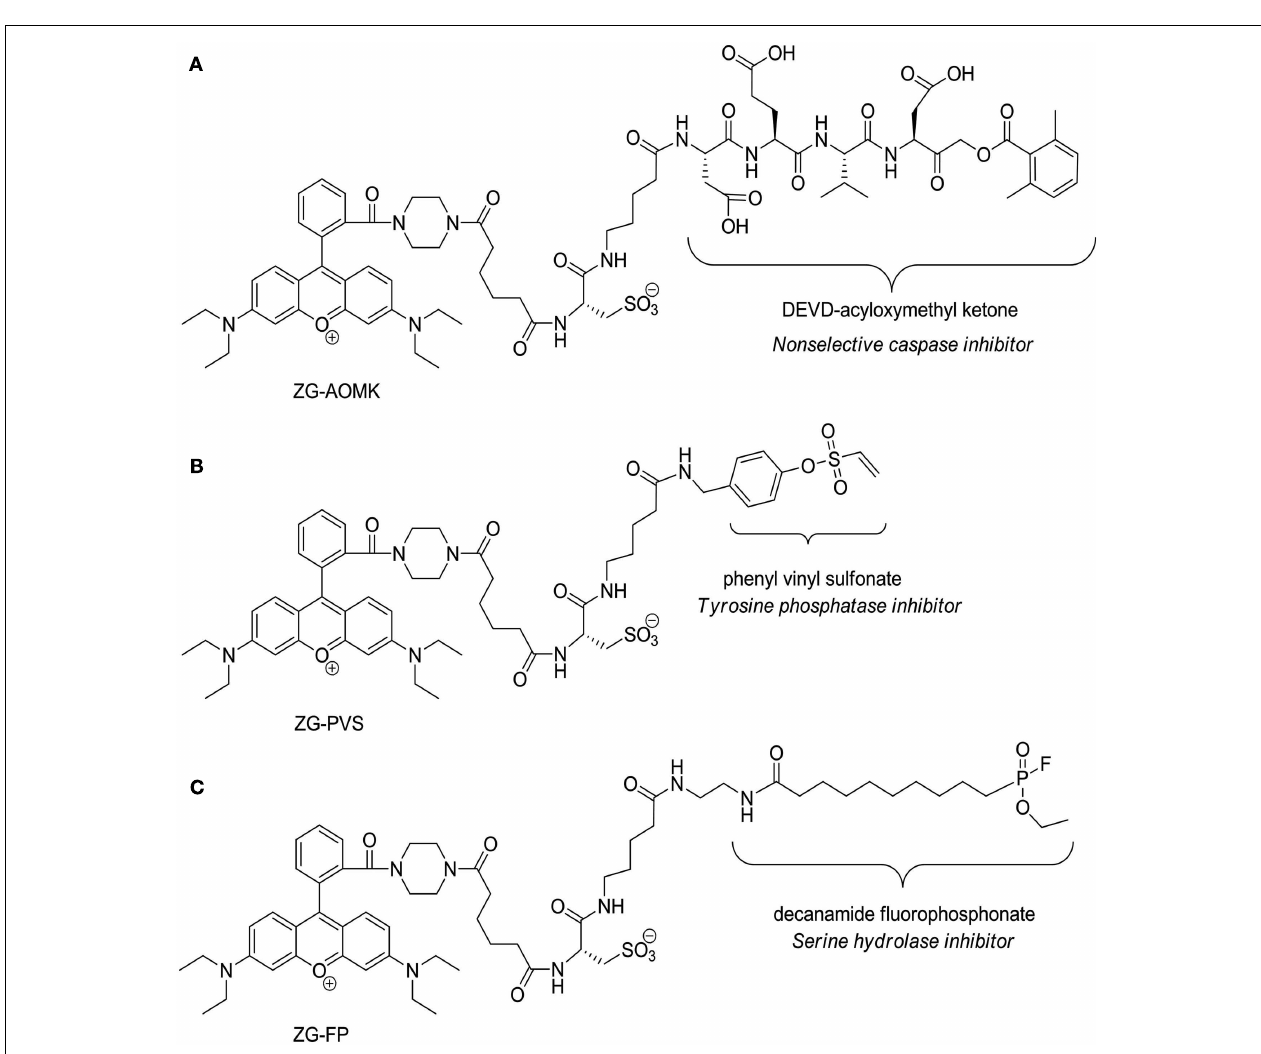
FIGURE 5 | Structures of the zwitterionicABPP probes. (A) Acyloxymethyl ketone probe (ZG-AOMK) for caspase. (B) Phenyl vinyl sulfonate probe (ZG-PVS) forTyrosine phosphatase. (C) Fluorophosphonate (ZG-FP) for Serine hydrolase. Note that the protein reactive functional groups are labeled and the protein classes to which they inhibit are denoted